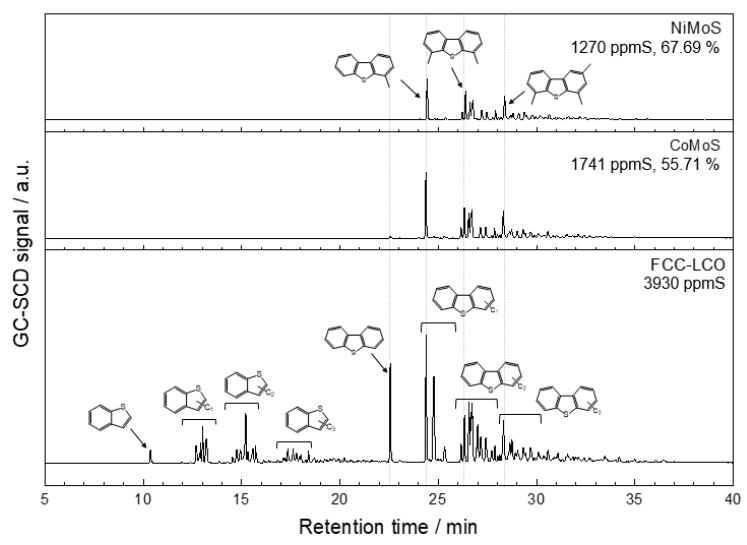
Figure 2. S compound distribution in LCO and after 2h of HDS over CoMoS and NiMoS catalysts at 613K .